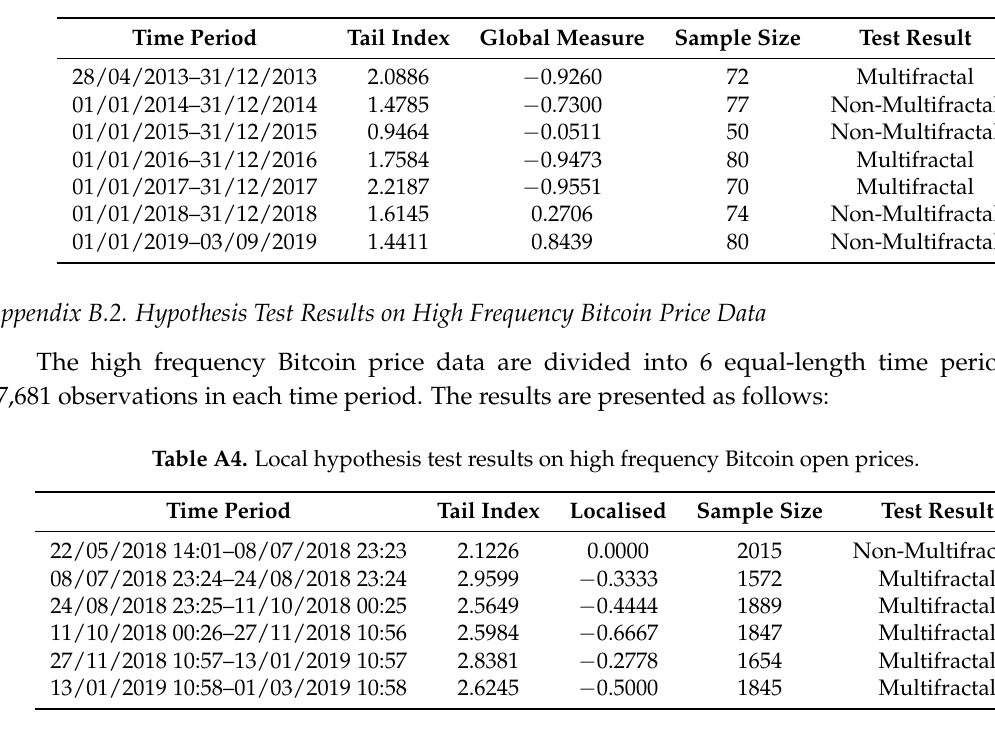
Table A3. Global Hypothesis test results on daily Bitcoin open prices.